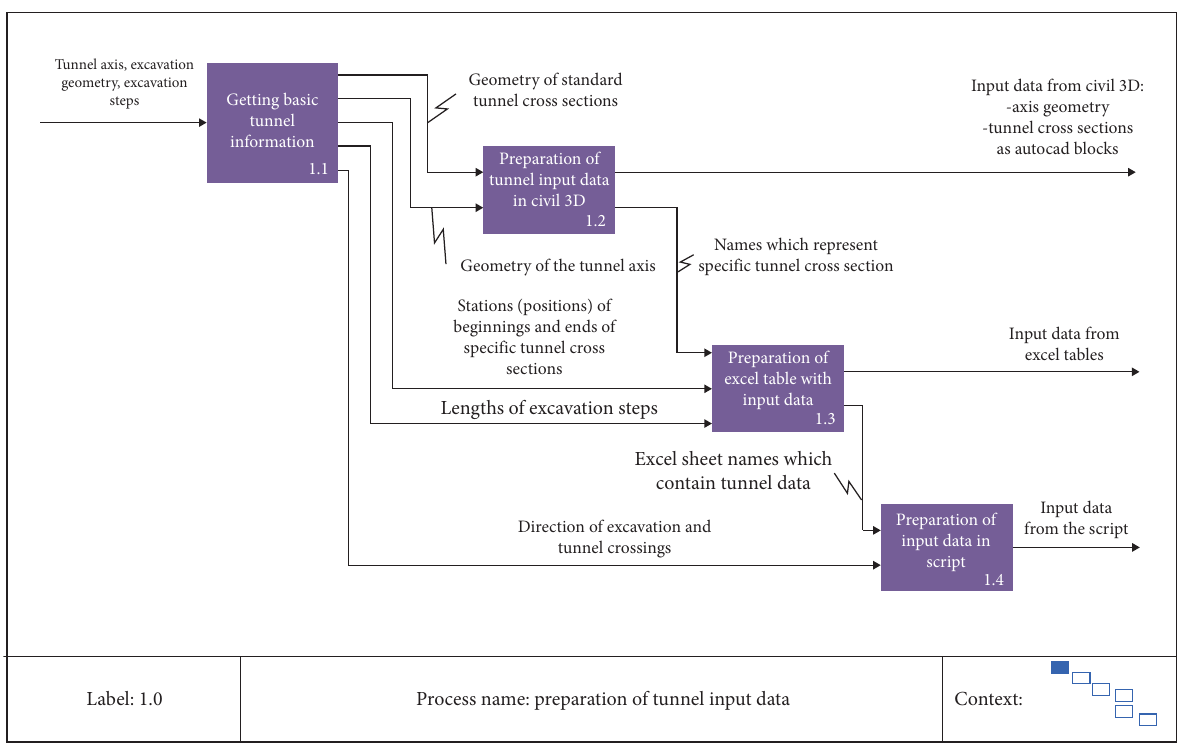
Figure 7: IDEF0 diagram: preparation of tunnel input